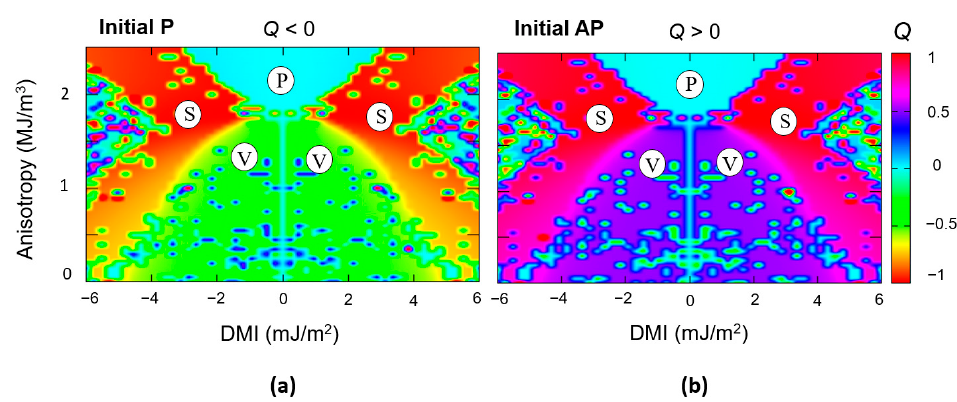
Figure 12. DMI-PMA-Q phase diagrams corresponding to simulation experiments started either from an initial P state ( a ) or an initial AP state ( b ). The parameters of the current pulse used in the simulation were: T pulse = 0.5 ns and J c = − 3 × 10 12 A/m 2 or J c = + 3 × 10 12 A/m 2 , depending on the initial P or AP state (WP in Figure 22a,d). The sign of the written skyrmion topological charge is opposite in the two situations.